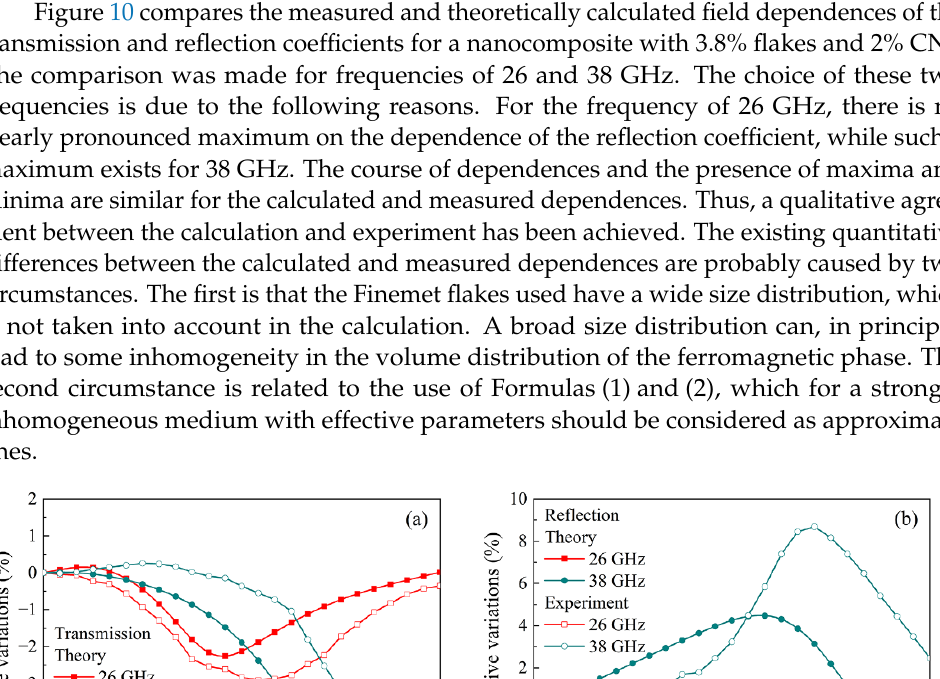
Figure 9. The dependence of the effective magnetic permeability on the magnetic field, calculated for several frequencies for a composite with 3.8% flakes and 2% CNT.